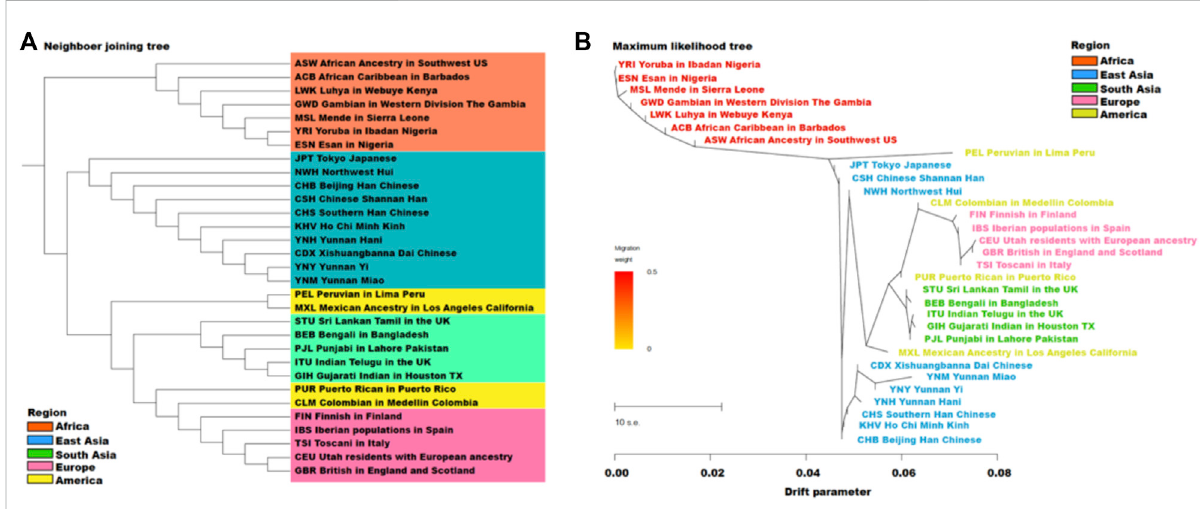
FIGURE 5 The neighbor joining tree (A) based on pairwise F ST genetic distances, and maximum likelihood tree (B) based on allele frequencies among Yunnan Yi, Hani, Miao groups and 28 reference